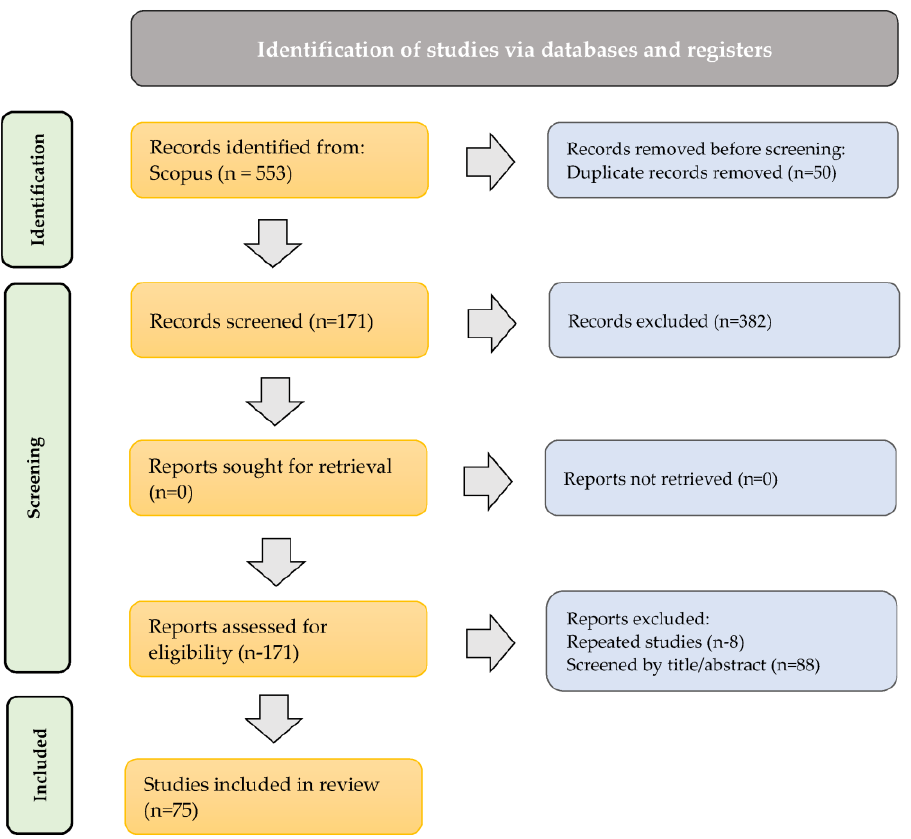
Figure 1. PRISMA flowchart showing how studies were chosen for systematic reviews.